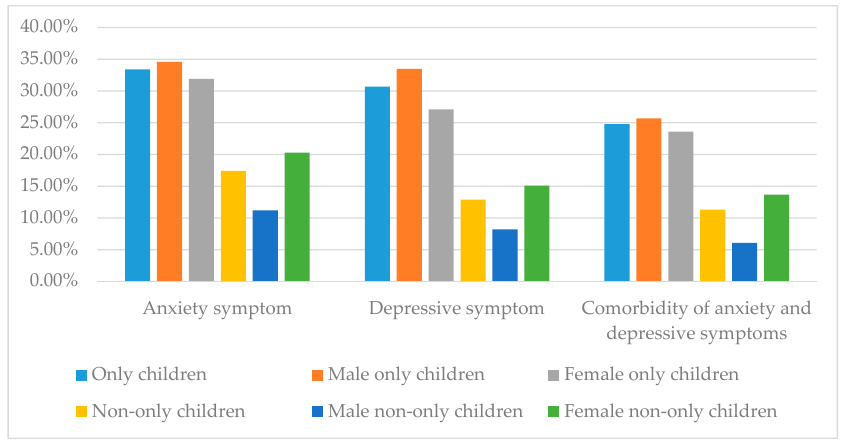
Figure 1. The prevalence rates of anxiety symptom, depressive symptom, comorbidity of anxiety and depressive symptoms among only children, non-only children and by gender.